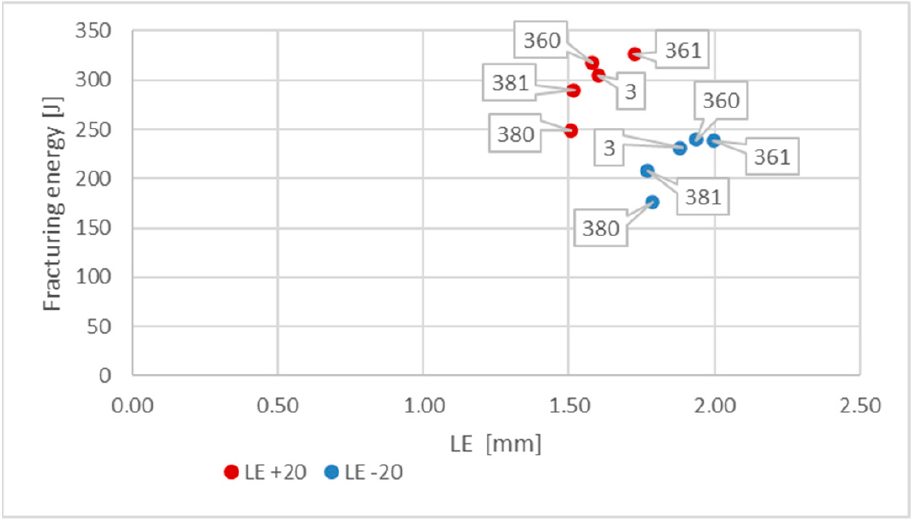
Figure 21. Relationship between averaged values of LE parameter and related values of fracturing energy obtained for X6CrNiTi18-10 steel at different testing conditions.